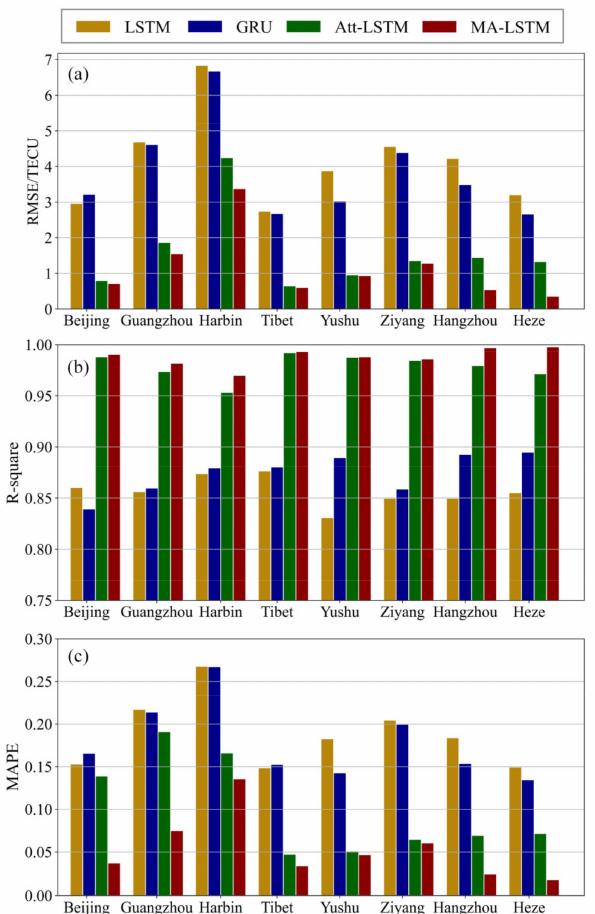
Figure 8. Comparison of ( a ) RMSE, ( b ) R-square, ( c ) MAPE values of different models in all